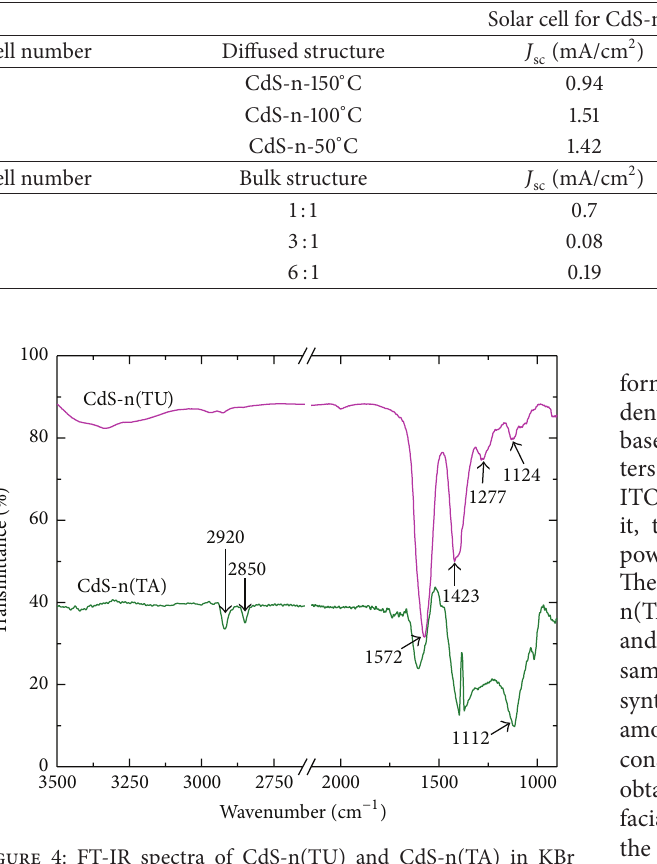
ers: CdS-n(TU):P3HT (Figure 5(a)) and